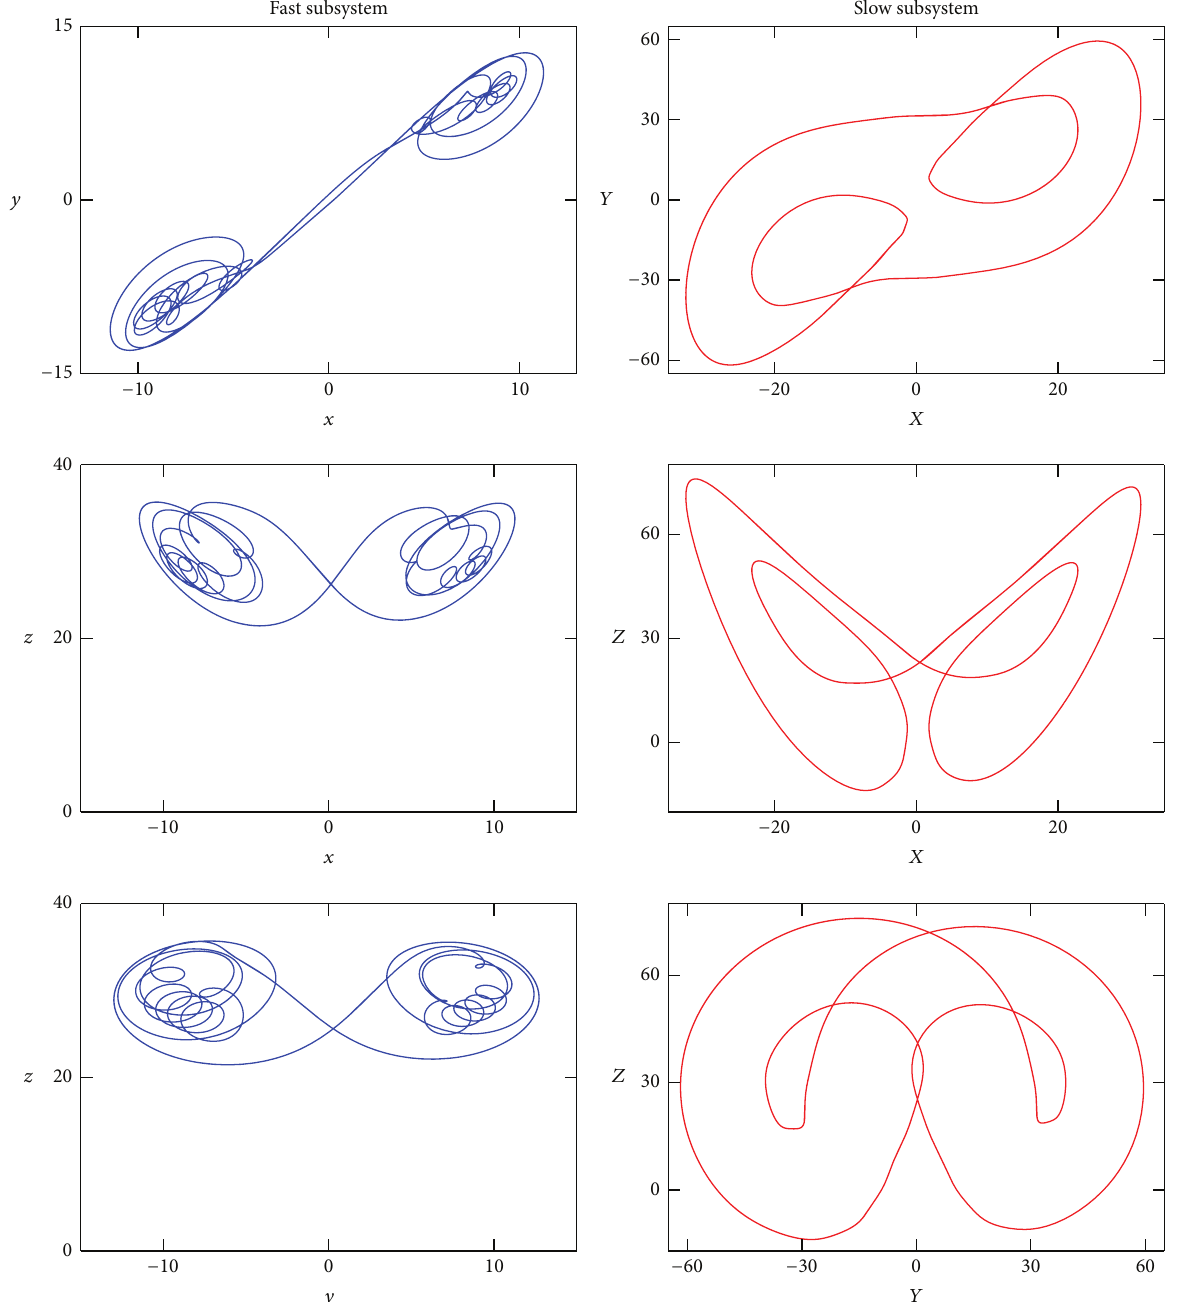
Figure 2: Phase portraits for fast and slow subsystems for 𝑐 = 0.8